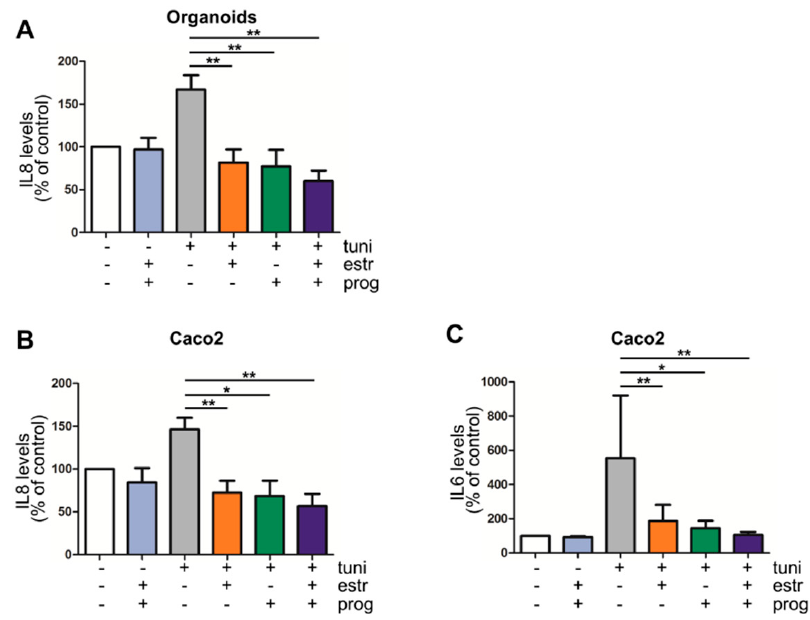
Figure 3. Progesterone and estrogen reduce IL6 and IL8 secretion in IBD inflammation models. Estrogen and progesterone significantly reduce IL8 production in an inflammation organoid model of IBD ( A ) (n = 9) as well as the Caco2 cell line model ( B ) (n = 4). IL6 production in Caco2 cells was also decreased by sex hormones ( C ) (n = 4). */** statistical significant ( p <